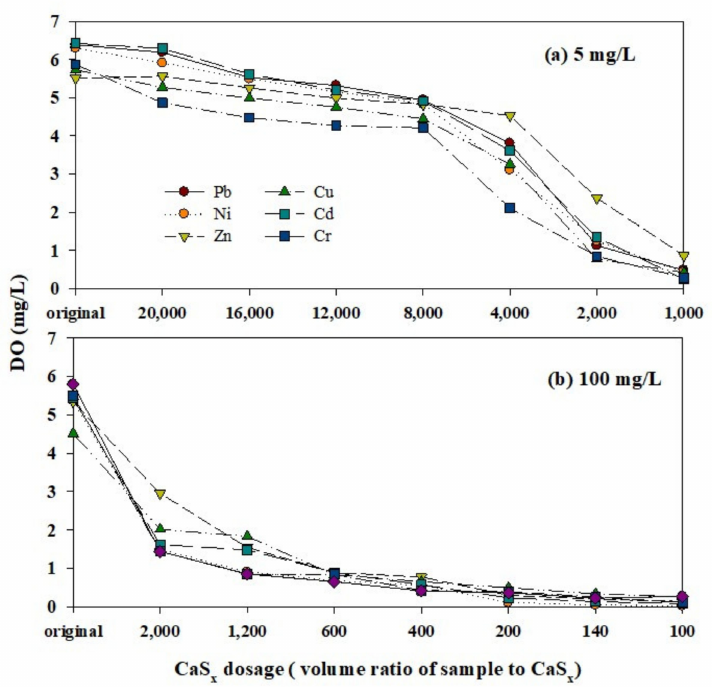
Figure 1. The changes of DO of various aqueous metals when different dosages of calcium polysulfide were added, ( a ) for concentration of 5 mg/L, ( b ) for concentration of 100